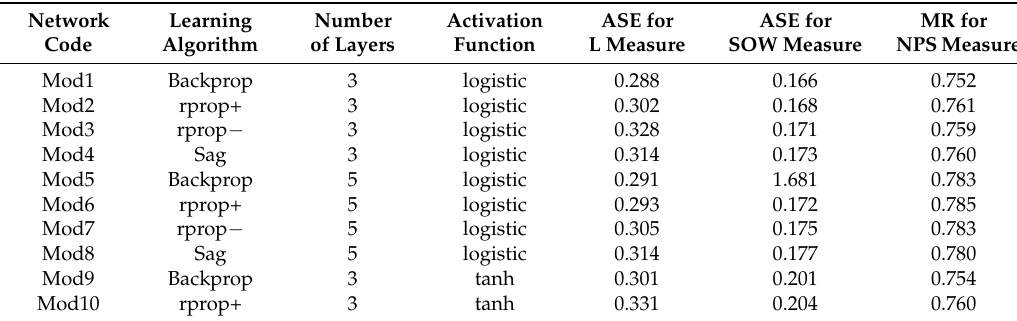
Table 1. Characteristics of analyzed neural